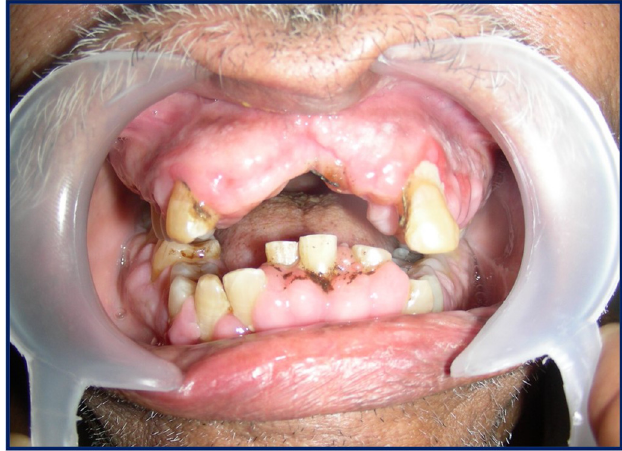
Fig. 5. Intraoral photograph postoperative follow-up after 1